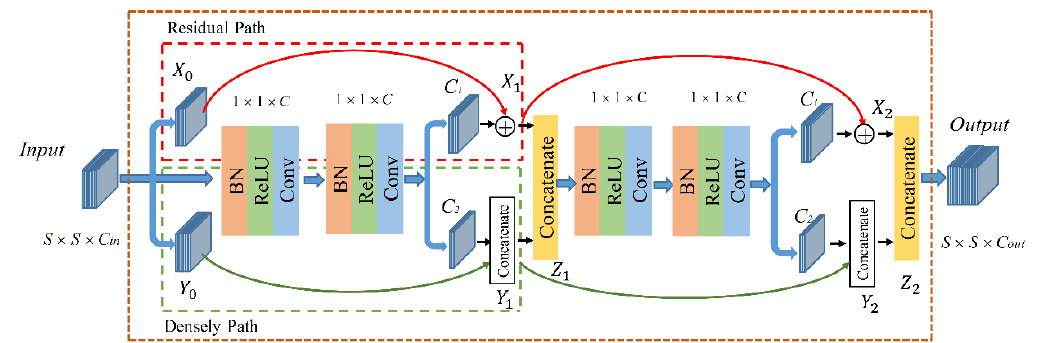
Figure 2. The Structure of the dual-path small convolution (DPSC) module.